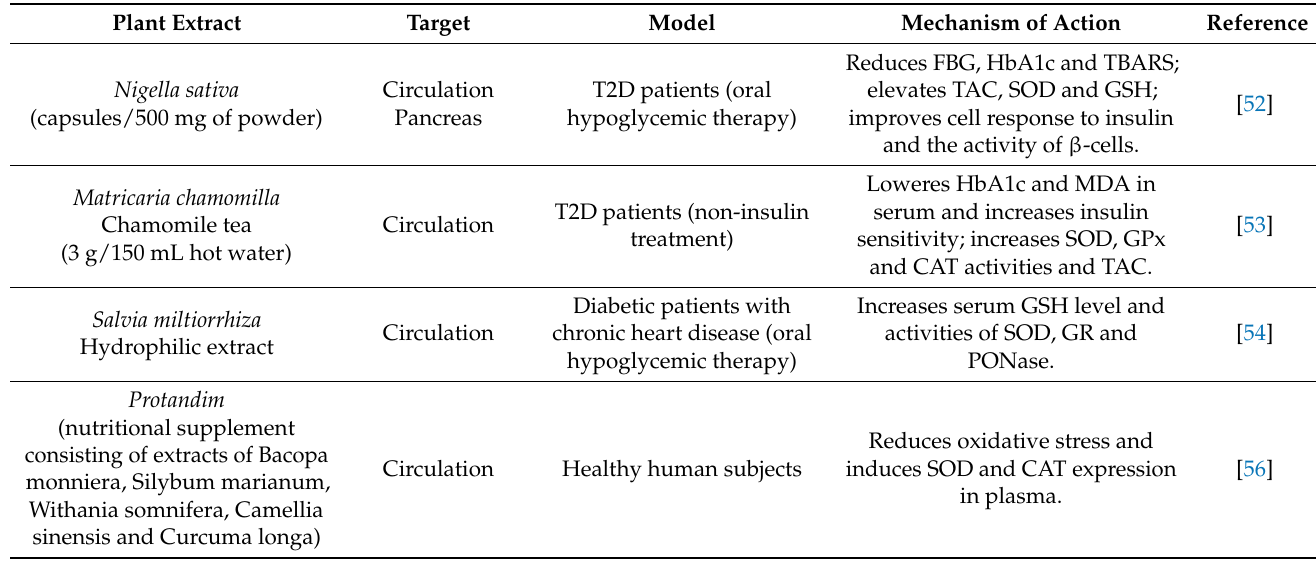
Table 3. Antidiabetic effects of plant extracts in clinical